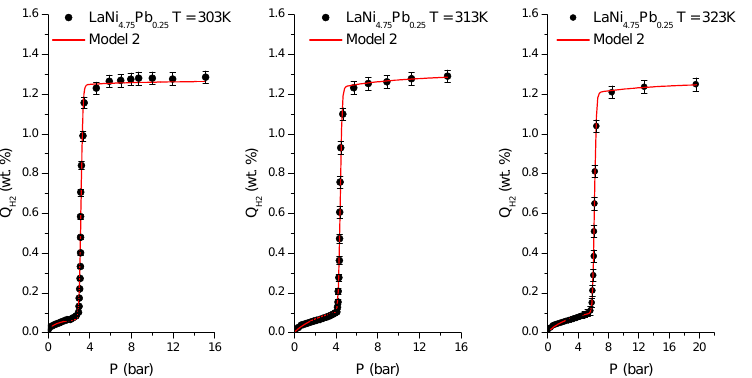
Figure 2. Hydrogen absorption isotherms for LaNi 4.75 Pb 0.25 at 303 K, 313 K, 323 K. The black circles are the experimental pcT data and the line is the simulation data obtained by using Model 2.